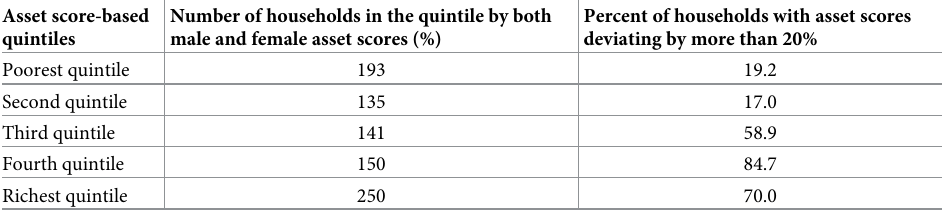
Table 5. Percent of households with the asset scores deviating by more than 20% among the households catego- rized in the same quintile by both male and female asset scores. Asset score-based